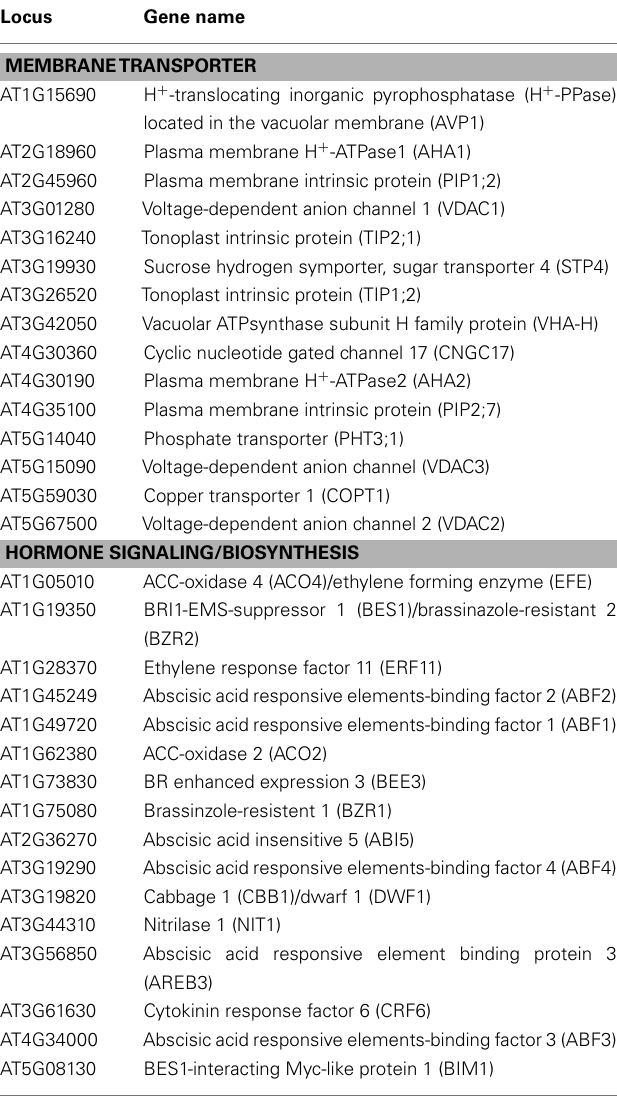
TableA1 | Results of a yeast two-hybrid screen using a cDNA library obtained from 3days old etiolated Arabidopsis seedlings (Kim et al., 1997) and different Arabidopsis 14-3-3 isoforms as a